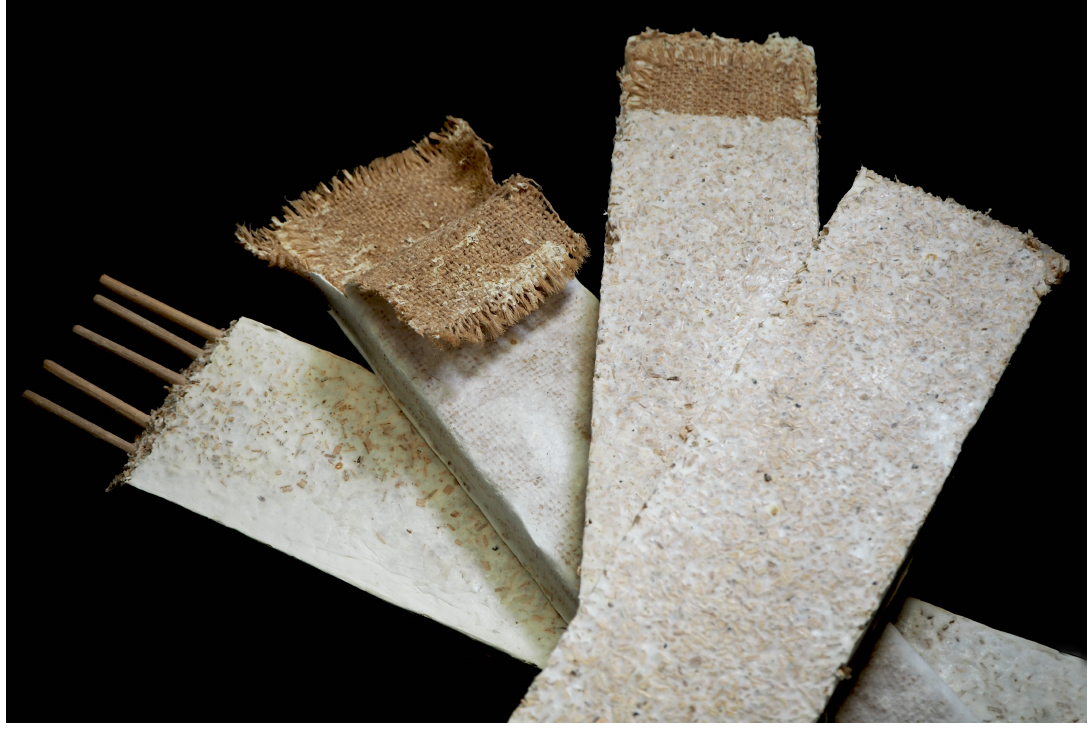
Figure 2. Fibre placement strategies in tested specimens (left to right): rattan fibres (BM_R), hessian jacketing (BM_H), inner hessian (BM_I), control